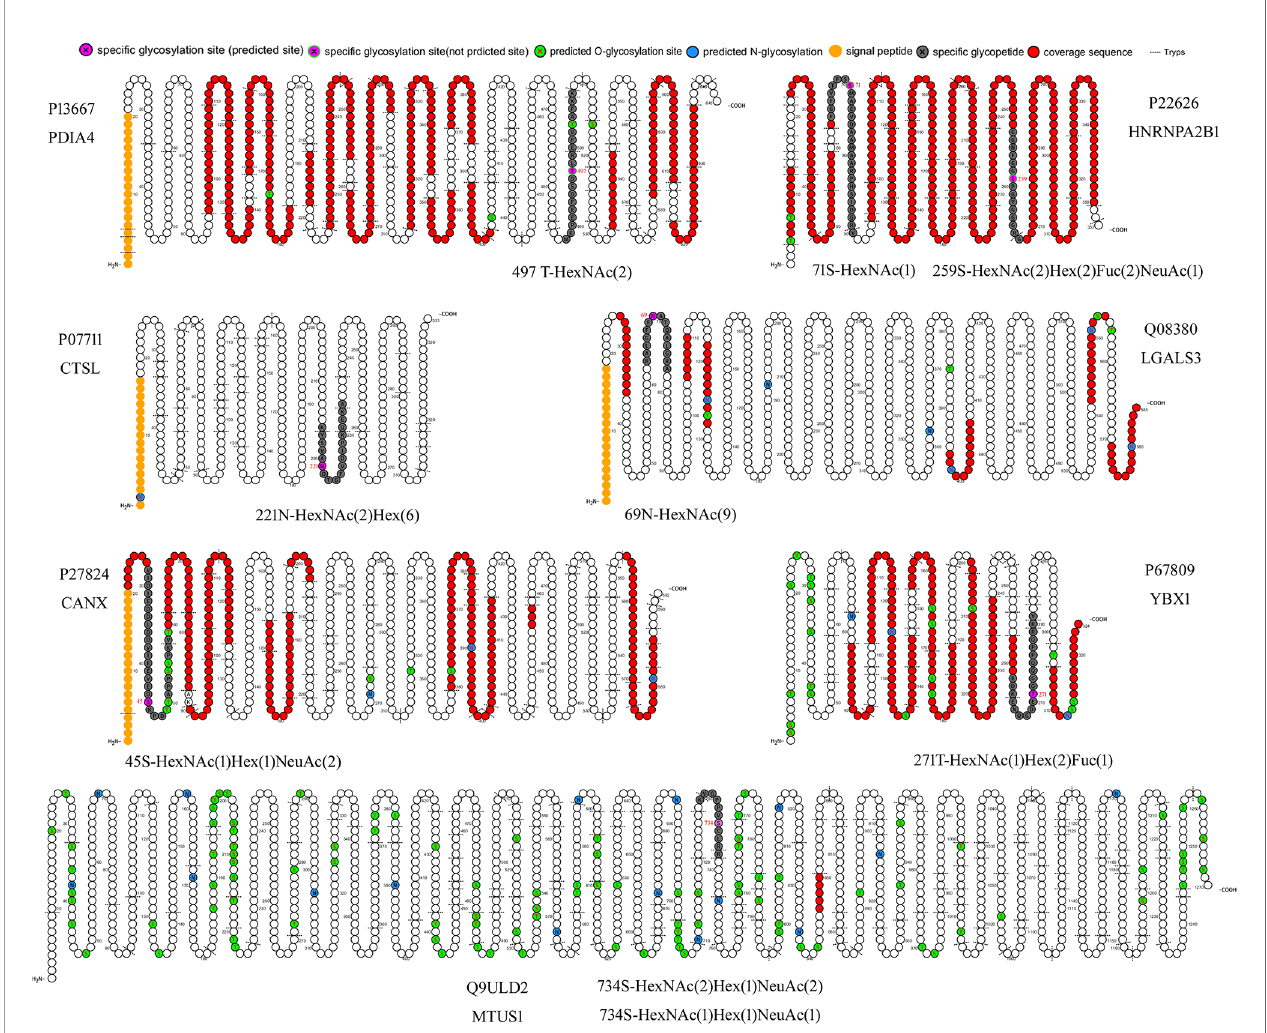
FIGURE 2 | Cartoon schematics of glycoproteins containing speci fi c glycosylated peptides related to gastric MALT lymphoma. The glycosylation sites 497T of PDIA4 and 71S of HNRNPA2B1 were present in only GMALT823 cells. The glycoforms HexNAc(2)Hex(6) and HexNAc(9) were absent at the glycosylation sites 221N of CTSL and 69N of LGALS3 in MALT823 cells, respectively. The glycosylation sites 734S of MTUS1, 45S of CANX, 271T of YBX1, and 259S of HNRNPA2B1 were stable in C823 and GMALT823 cells. The MTUS1 protein could not be expressed in GAT823, GAU823 and GAC823 cells. Glycosylation sites and glycoforms in the blue, yellow and green frames are present in only GMALT823 cells, absent in GMALI823 cells and steady in GAMALT823 and C823 cells,